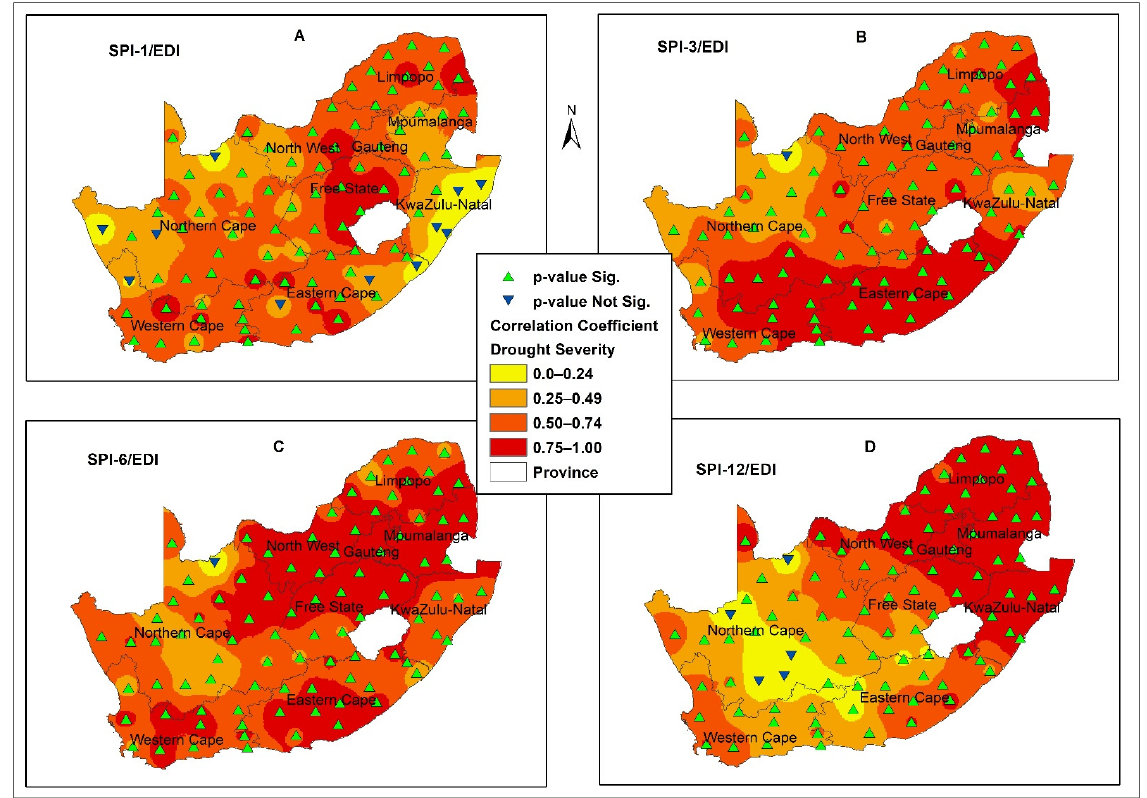
Figure 5. Pearson’s correlation coefficient estimates dissimilarity measure for drought severity in South Africa. ( A ) SPI- 1/EDI; ( B ) SPI-3/EDI; ( C ) SPI-6/EDI; and ( D ) SPI-12/EDI.